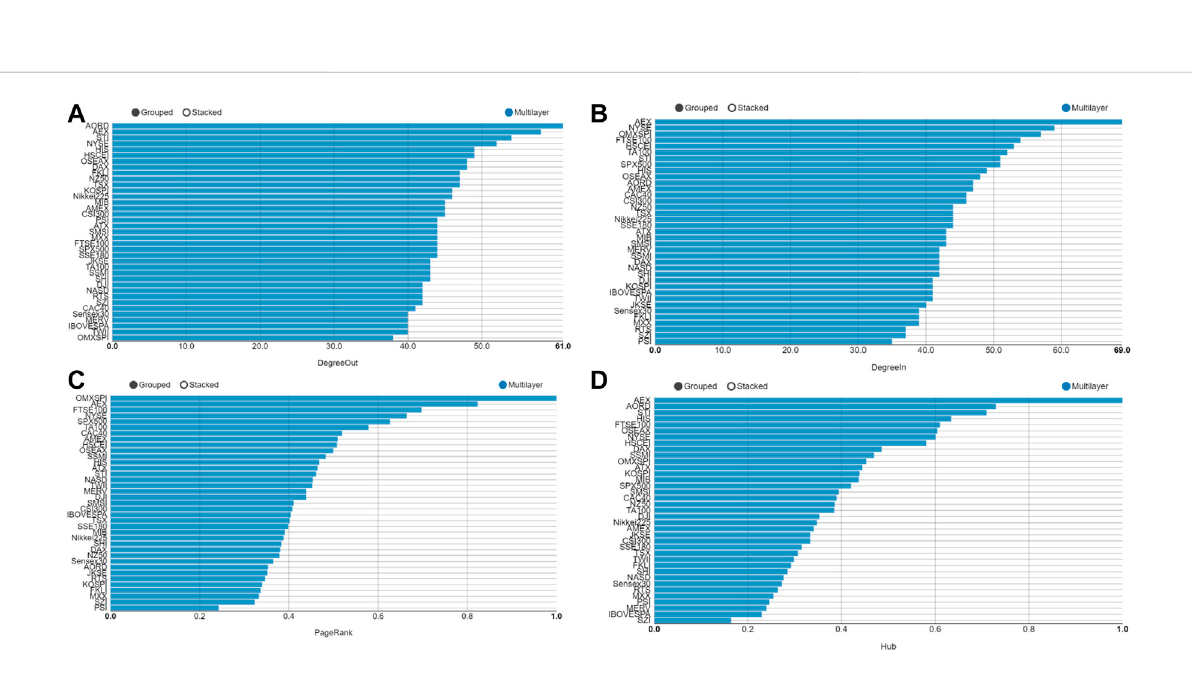
FIGURE 11 Parameters of the multilayer network at the time of European subprime mortgage crisis. (A) The out-degree of the multilayer network; (B) The in-degree of the multilayer network; (C) The PageRank of the multilayer network; (D) The hub of the multilayer